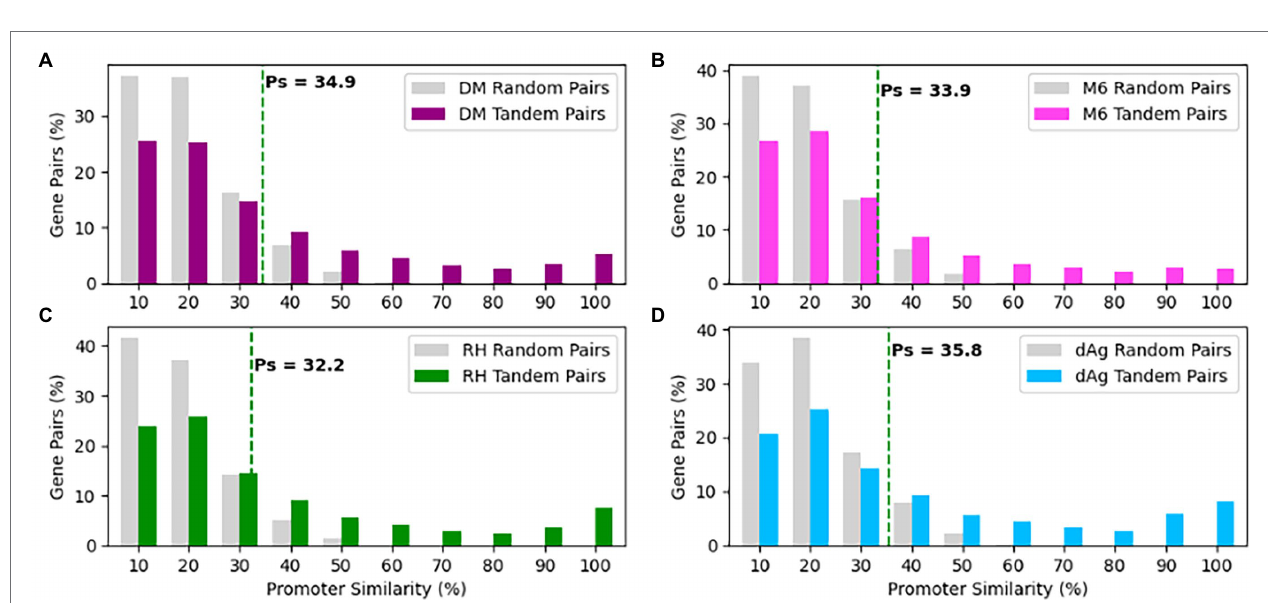
FIGURE 6 | Distributions of Pearson’s correlation coefficient ( r ) between the expression profiles of two copies derived from tandem duplication in (A) DM, (B) M6, (C) RH, and (D) dAg. The dashed green line indicates the 95% quantile of r distribution of random gene pairs in respective genotypes. r < 95% quantile indicates that the gene pairs have diverged expression, while r ≥ 95% quantile indicates that the gene pairs have conserved expression in respective potato genomes.